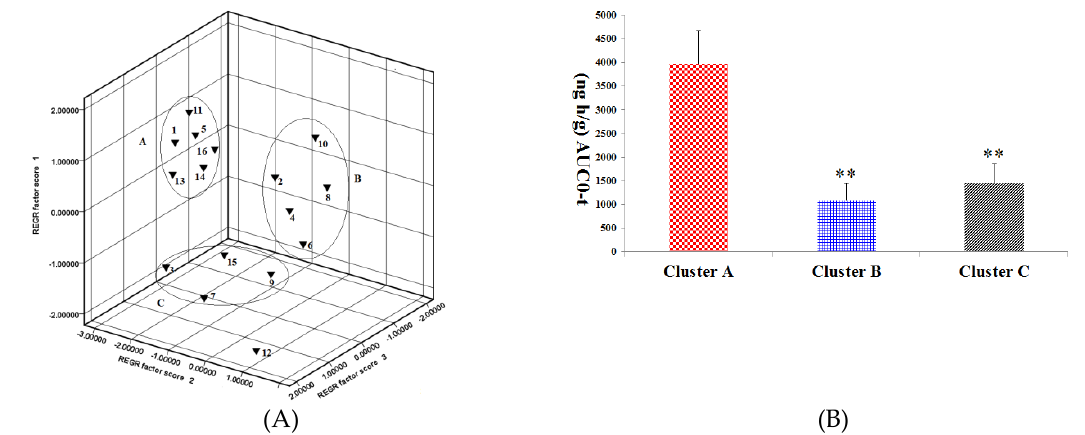
Figure 4. ( A ) Principal component analysis (PCA) scores plot of the 16 ginsenosides absorbed in rat plasma after oral administration of RGS. 1: Rg1, 5: Rg2, 11: Rh4, 13: Rk1, 14: Rg5 and 16: Rh3 were